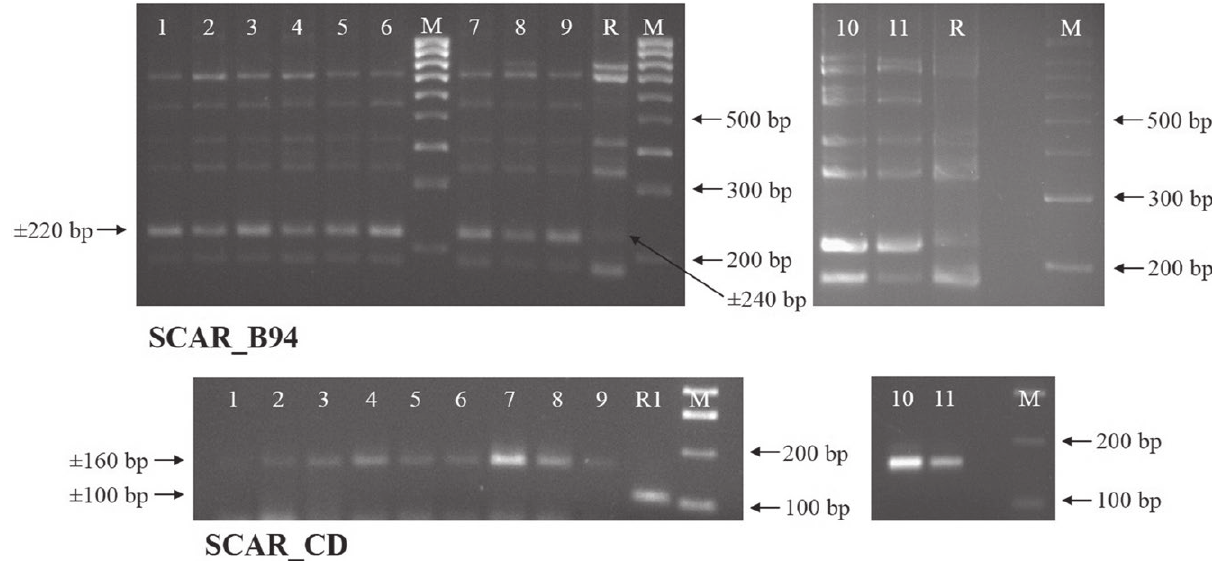
Figure 2. DNA amplification products from pepper cultivars ( Capsicum annuum ), using SCAR_B94 linked to the Me3 gene and SCAR_CD linked to Me1 and Me7 . Band 1, ‘Yolo Wonder’; 2, ‘Amarelo’; 3, ‘Vermelho’; 4, ‘Celta’; 5, ‘Cláudio’; 6, ‘Rialto’; 7, ‘Solero’; 8, ‘Tauro’; 9, ‘Tor- pedo’; 10, ‘Yoacali’; 11, ‘Raimbom’; R, ‘DH149’; R1, ‘DH330’; M, DNA marker (HyperLadder IV,